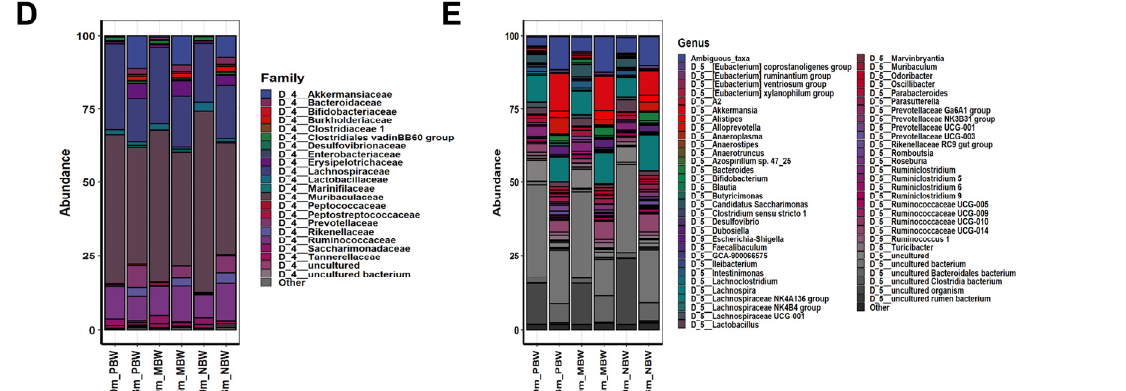
Figure 2. The gut microbiome composition before and after gut microbiome replacement in the experimental mice. The relative compositional changes in the gut microbiome at the ( A ) phylum, ( B ) class, ( C ) order, ( D ) family, and ( E ) genus levels. For the abundance values of all groups, the average abundance values of individuals belonging to each group were used.